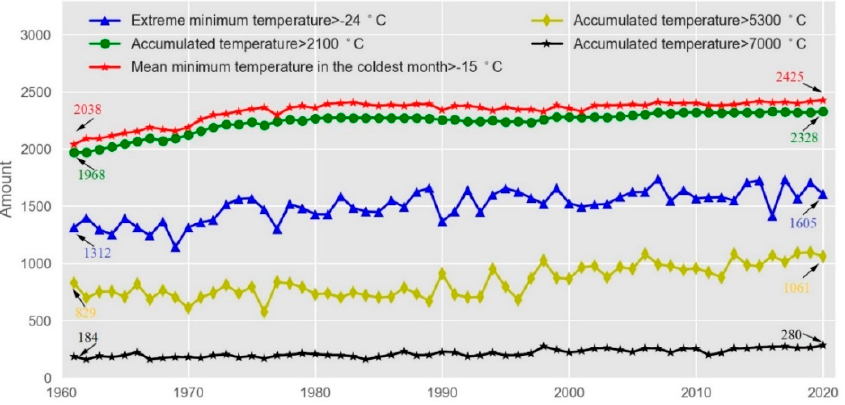
Figure 7. The amount of weather stations that meet a certain condition of each year during 1961–